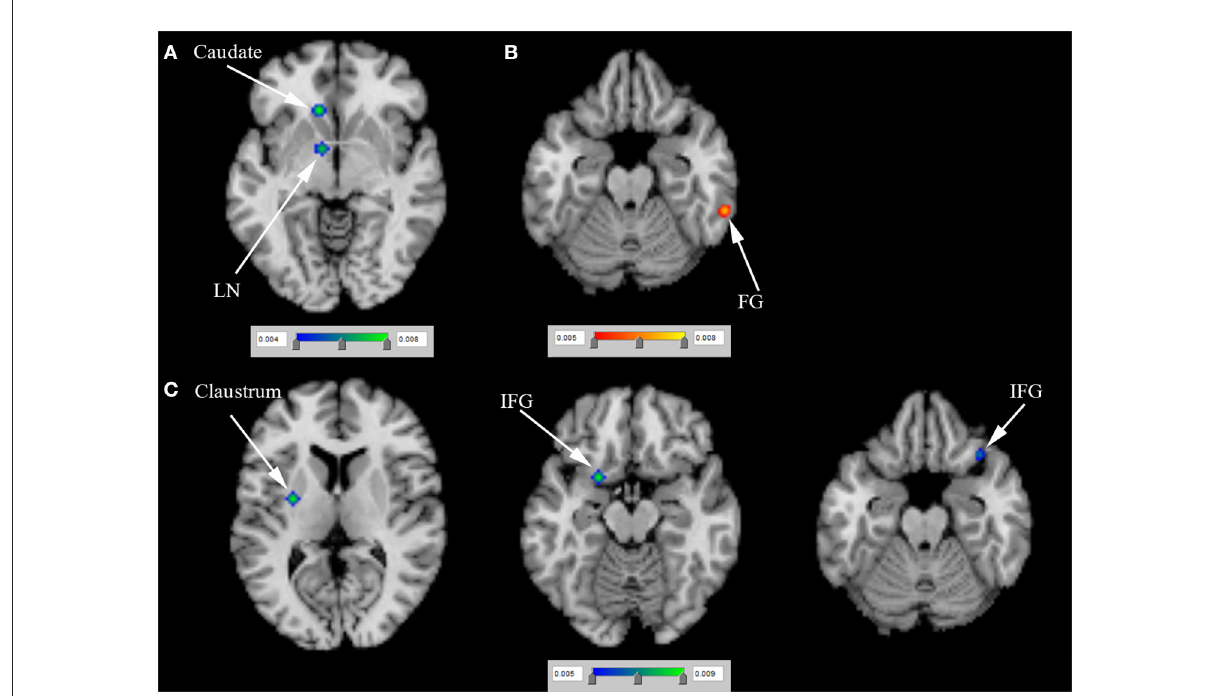
FIGURE5 (A) Reduced rCBF (in blue), (B) increased rCBF (in red) using PET and (C) reduced rCBF (in blue) using SPECT in PD-ICD patients, compared to PD-no ICD. FG, fusiform gyrus; ICD, impulse control disorder; IFG, inferior frontal gyrus; LN, lentiform nucleus; PD, Parkinson’s disease;